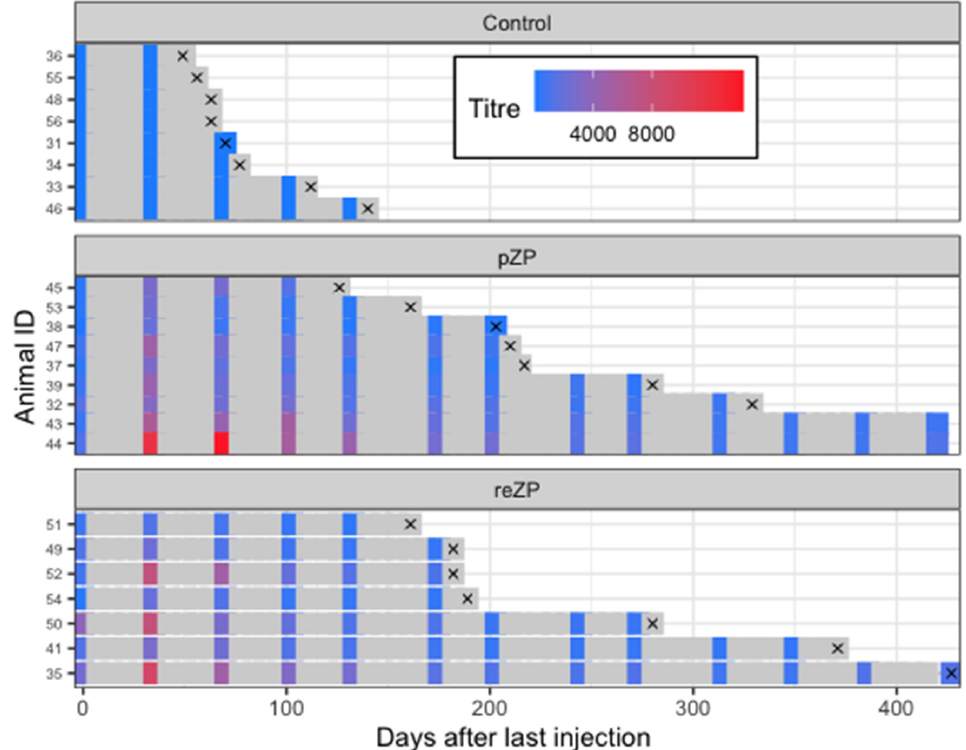
Figure 5. Timelines arranged by treatment groups (Control, reZP and pZP) and individual jennies from day of final immunisation (Day 0) through to study exit. Anti-pZP antibody titres status is indicated by the color (refer to color chart) of the squares on the days of sample collection. The symbol ‘×’ denotes diagnosis of pregnancy. Table 2. Anti-pZP antibodies titres at Day 35 in jennies vaccinated with recombinant zona pellucida (reZP), porcine native zona pellucida (pZP) vaccines, or placebo (Control).